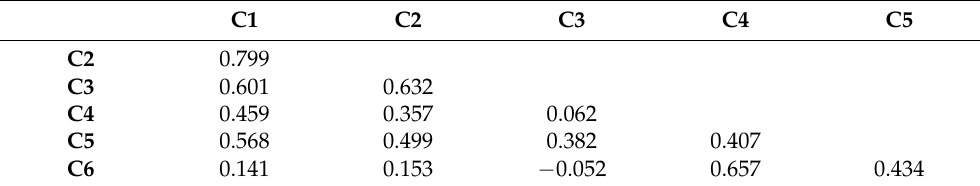
Table 6. Correlation matrix for questions’ responses. Table 6 . Correlation matrix for questions’ responses.